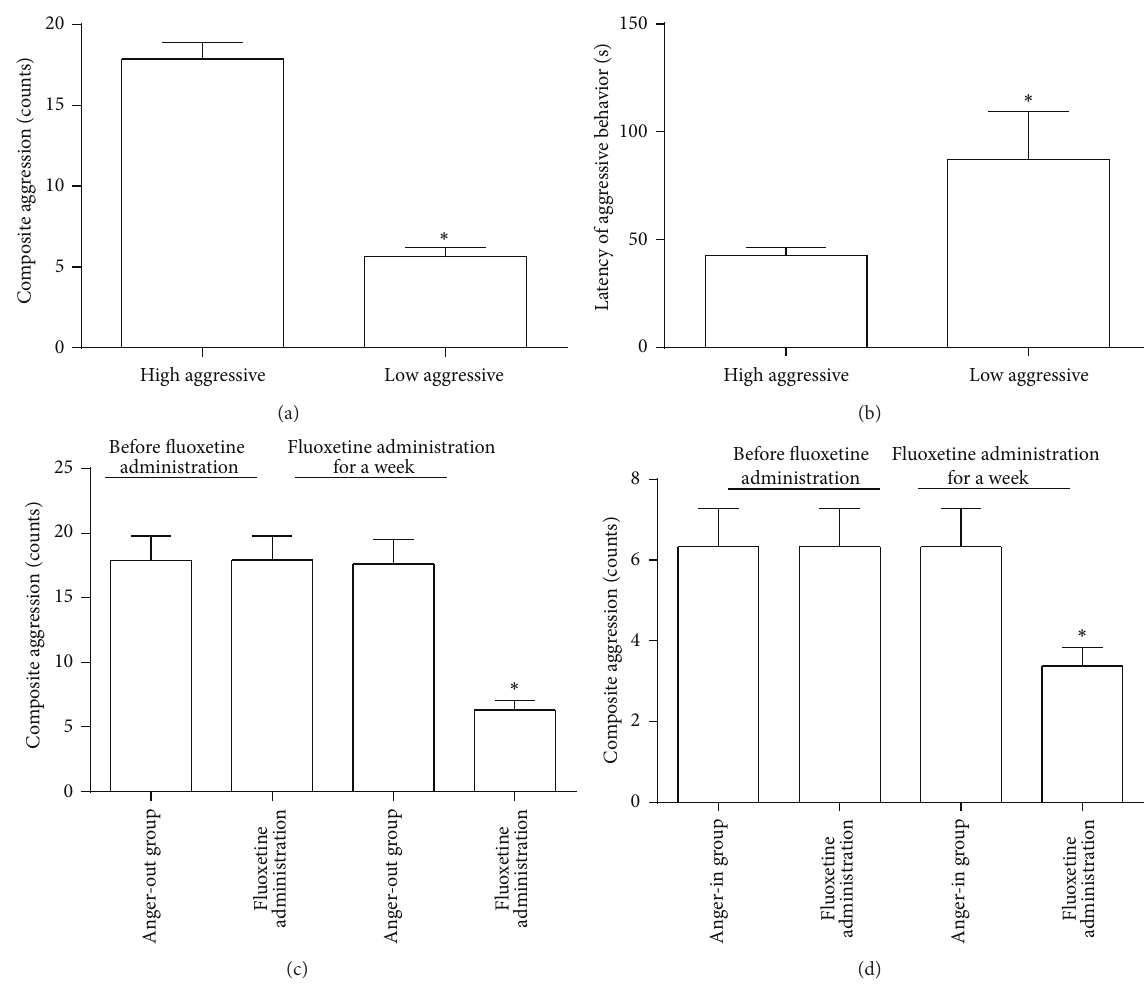
Figure 1: (a) Composite aggression scores of HA group and LA group ( 𝑛 = 36 , ∗ 𝑃 < 0.05 ). (b) Latency of aggressive behavior of HA group and LA group ( 𝑛 = 36 , ∗ 𝑃 < 0.05 ). (c) Composite aggression scores of anger-out group before and after fluoxetine administration ( 𝑛 = 12 , ∗ 𝑃 < 0.05 ). (d) Composite aggression scores of anger-in group before and after fluoxetine administration ( 𝑛 = 12 , ∗ 𝑃 < 0.05